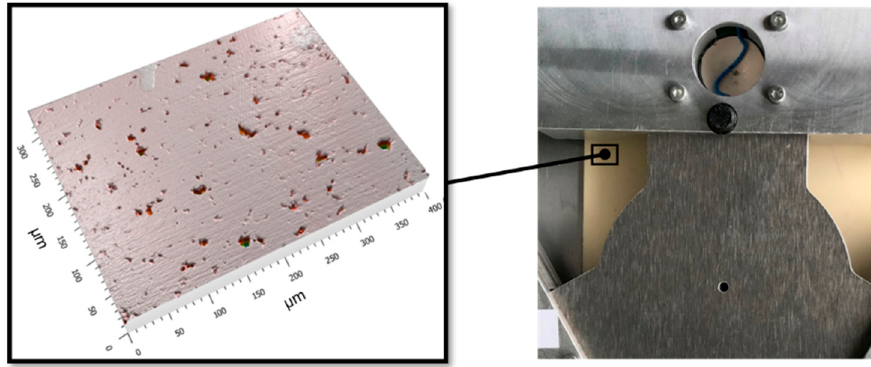
Figure 4. Magnified view of the surface of the ceramic base plate.